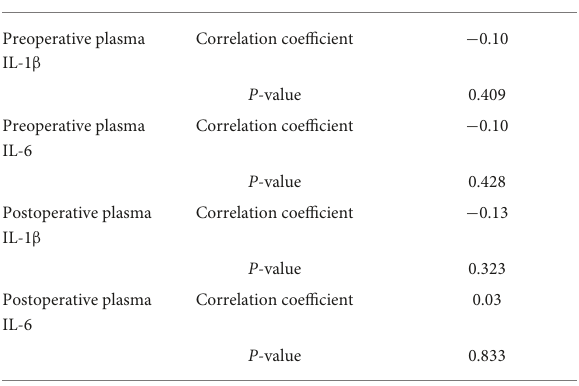
TABLE 3 Pearson correlation analysis between visfatin and inflammation factors when visfatin concentrations was above 37.87